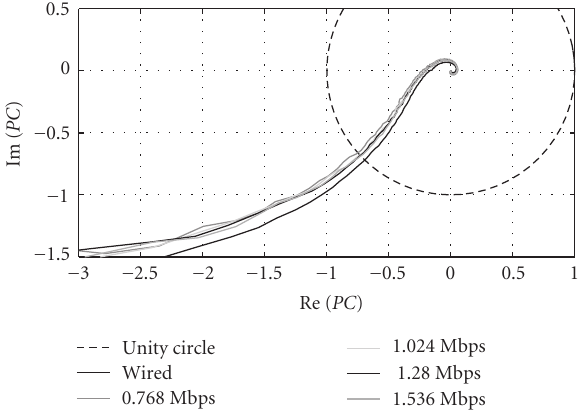
Figure 11: Nyquist plot of wired and wireless open loop transfer function PC